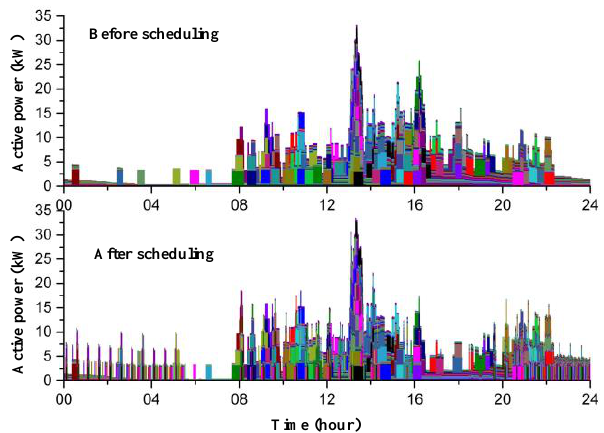
Figure 11. Real time active power consumption of 100 domestic electric water heaters based on the temperature state priority list method.